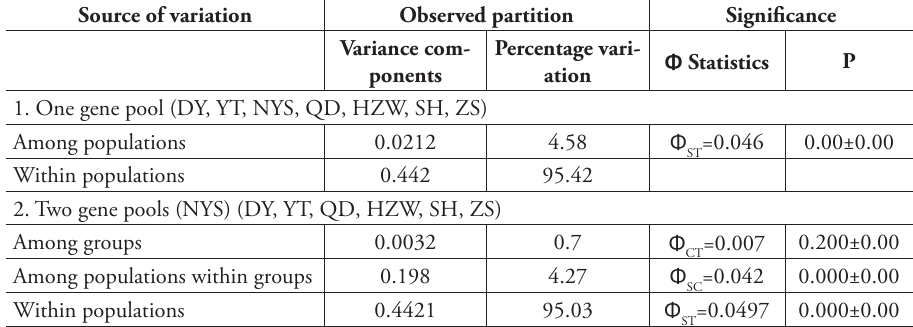
Table 3. AMOVA of J. grypotus populations based on mtDNA control region sequences